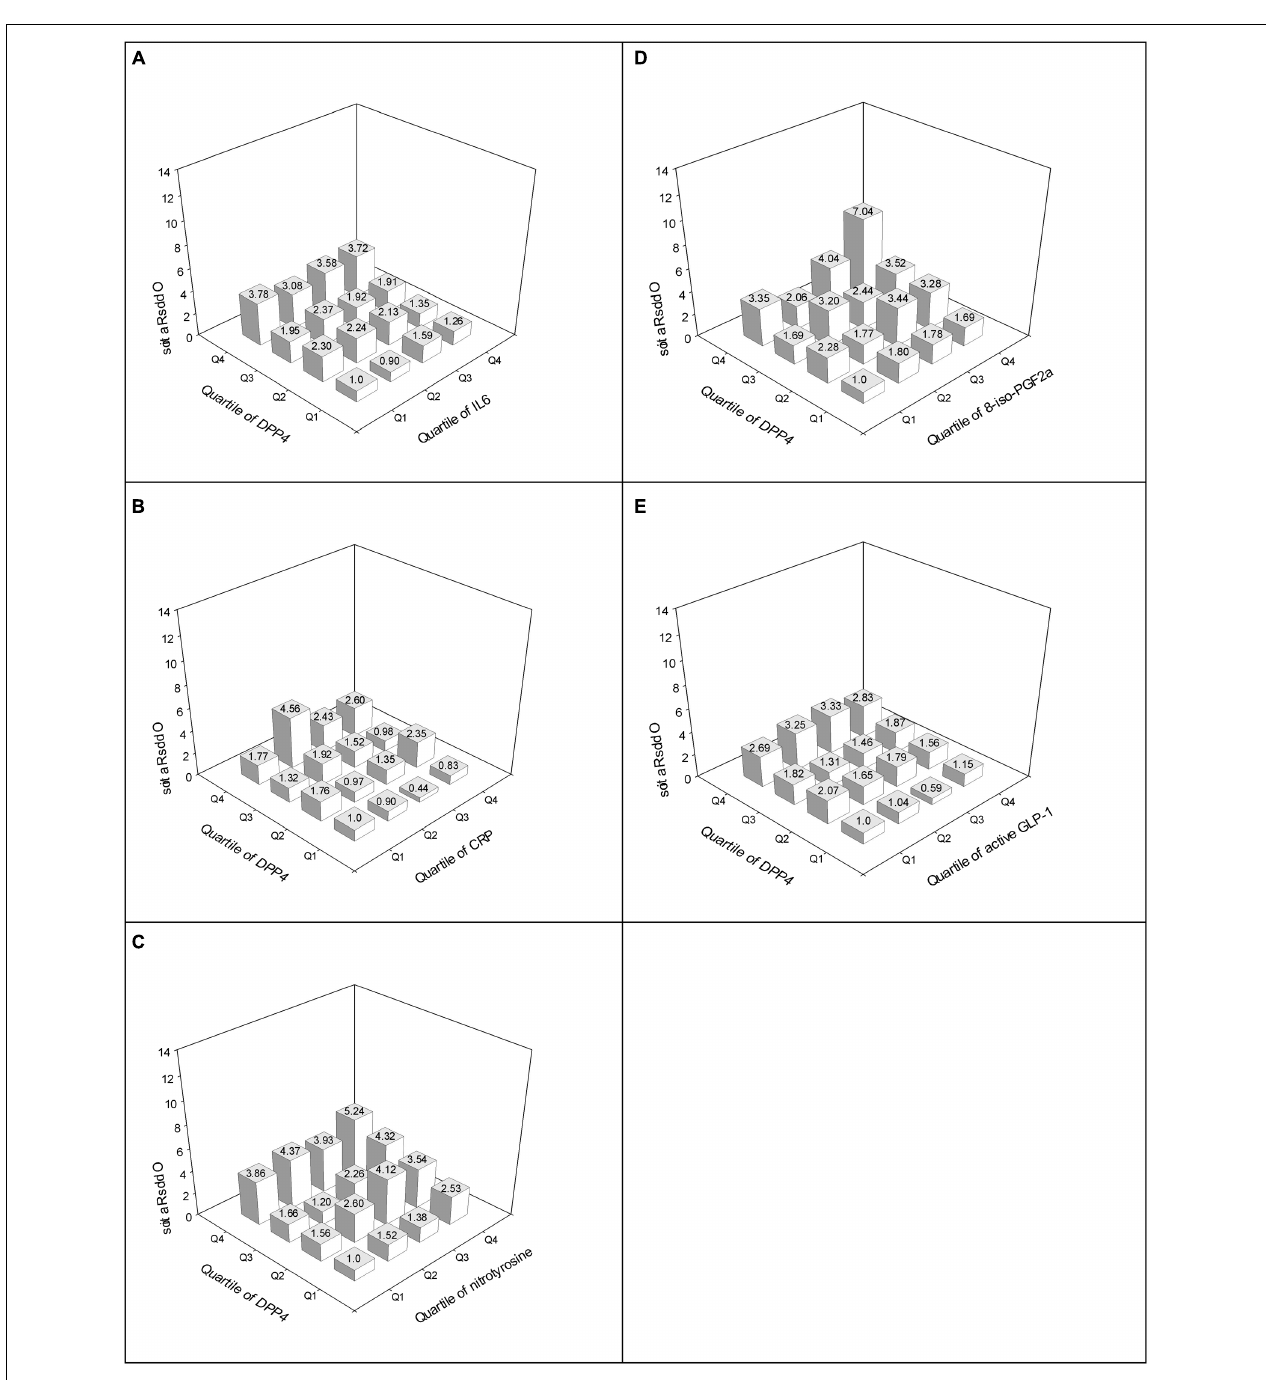
FIGURE 2 | Adjusted ORs for impaired cognitive function according to the quartiles of DPP4 activity and IL-6 (A) , DPP4 activity and CRP (B) , DPP4 activity and nitrotyrosine (C) , DPP4 activity and 8-iso-PGF2a (D) , and DPP4 activity and fasting active GLP-1 (E) . Adjusted for age, gender, BMI, current smoking, habitual alcohol consumption, leisure-time physical activity, education level, annual income, cardiovascular disease, statin use, NSAID use, SBP, TG, HDL-C.